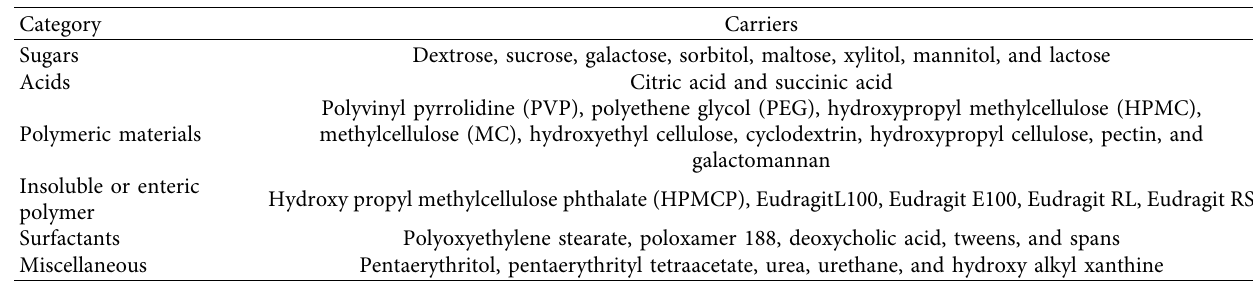
Figure 1: Schematic representation of the solid dispersion types [15]. Table 3: Different carriers used in solid dispersion